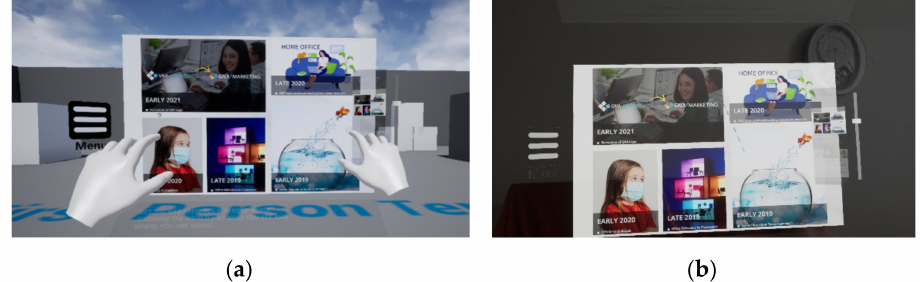
Figure 1. The Framework Prototype in Web XR: ( a ) Navigation System in the VR environment; ( b ) 3D Page Layout in an MR